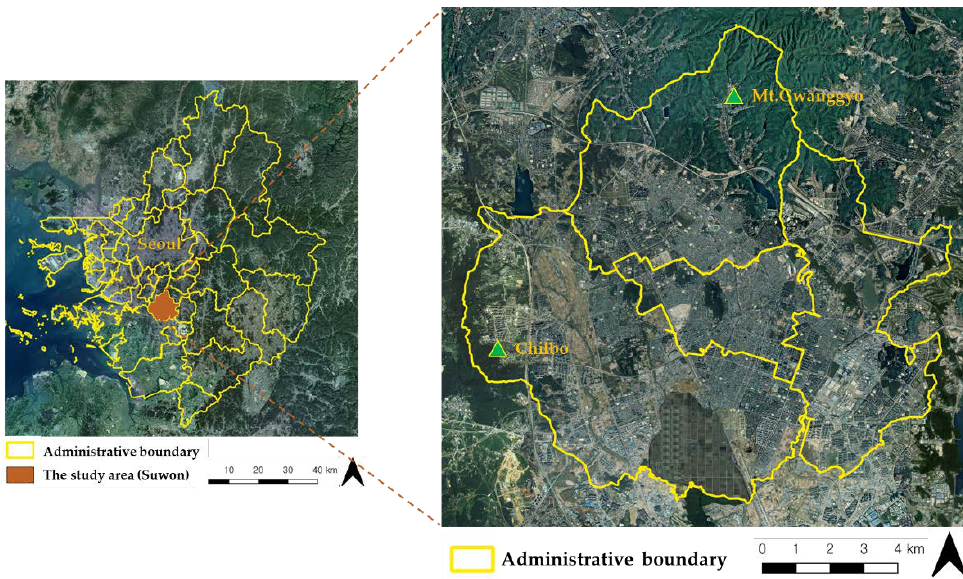
Figure 2. The study area (Suwon City, South Korea) (https://map.kakao.com/, accessed on 1 June 2021).